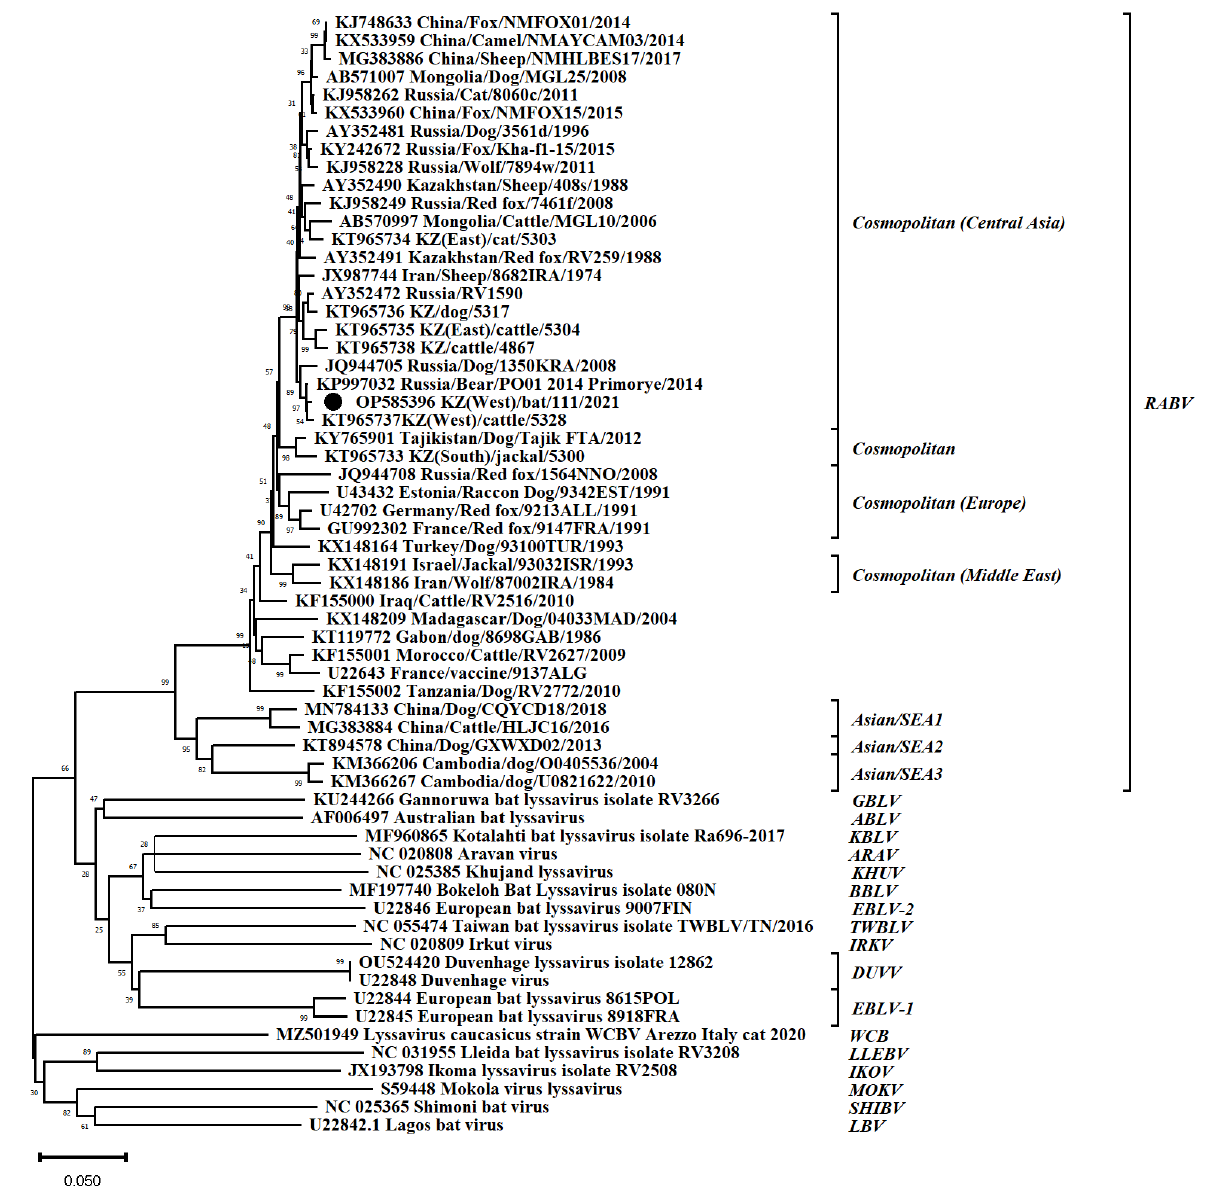
Figure 6. Phylogenetic analysis of nucleotide sequences of the nucleoprotein gene (N-gene) of the rabies virus.